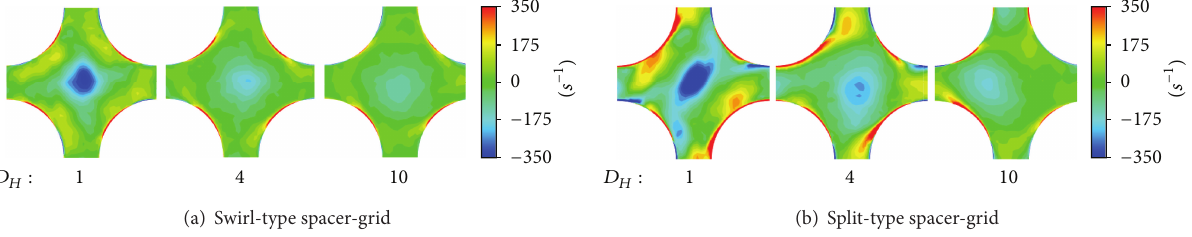
Figure 20: Vorticity contours at 1 𝐷 𝐻 , 4 𝐷 𝐻 , and 10 𝐷 𝐻 downstream of the